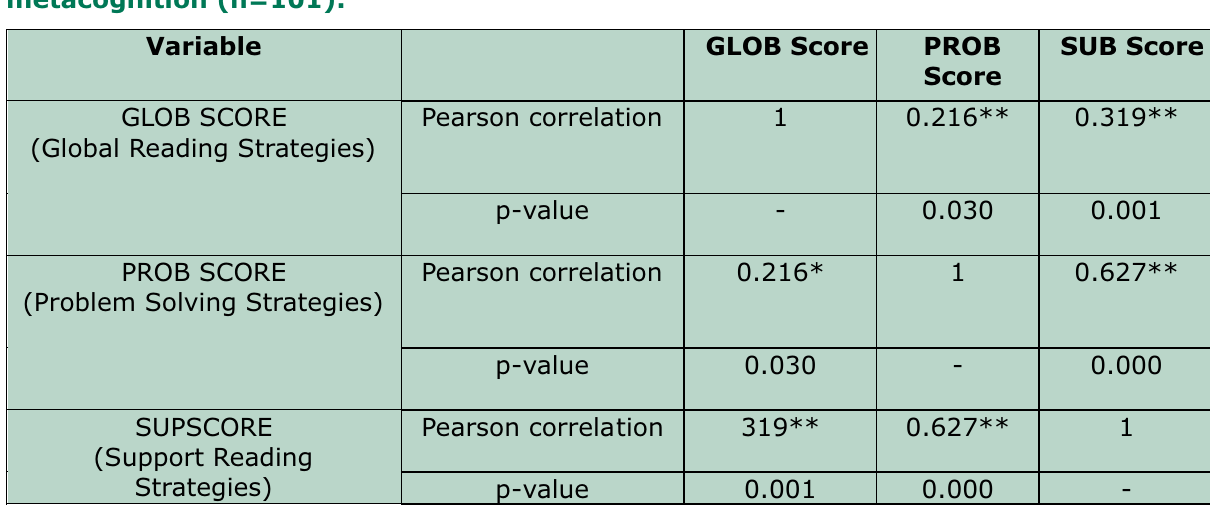
Figure-II: Multi bar Chart Description of Quantitative variables of study. Table-II: Pearson Product-moment Correlation between strategy subcategories of metacognition